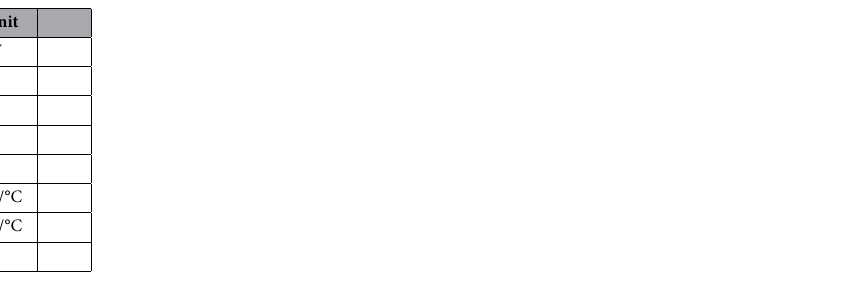
Table 1. Parameters of the NST-120 PV panel at STC from the datasheet.